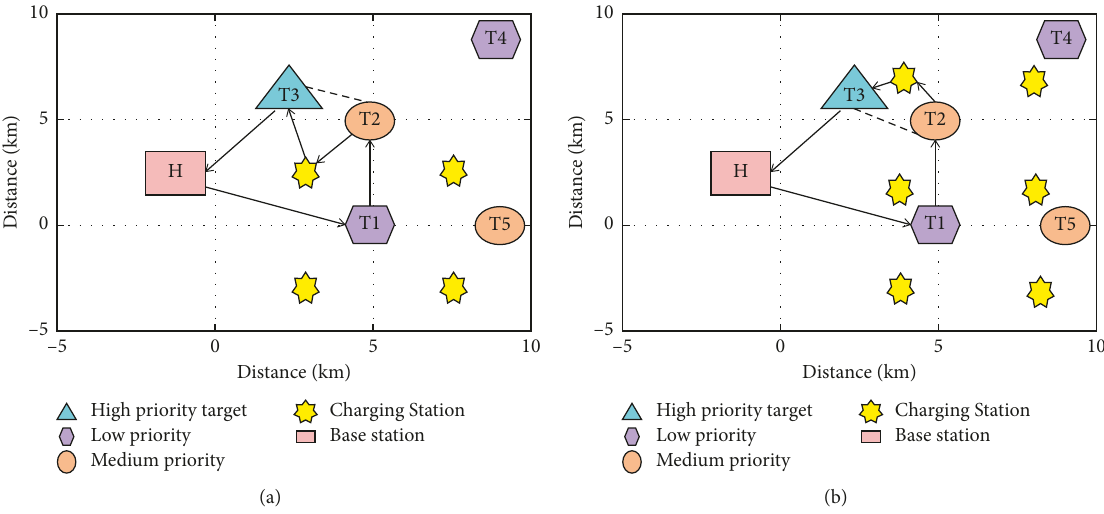
Figure 2: Two different drone routes for the same targets of (a) four charging stations and (b) six charging